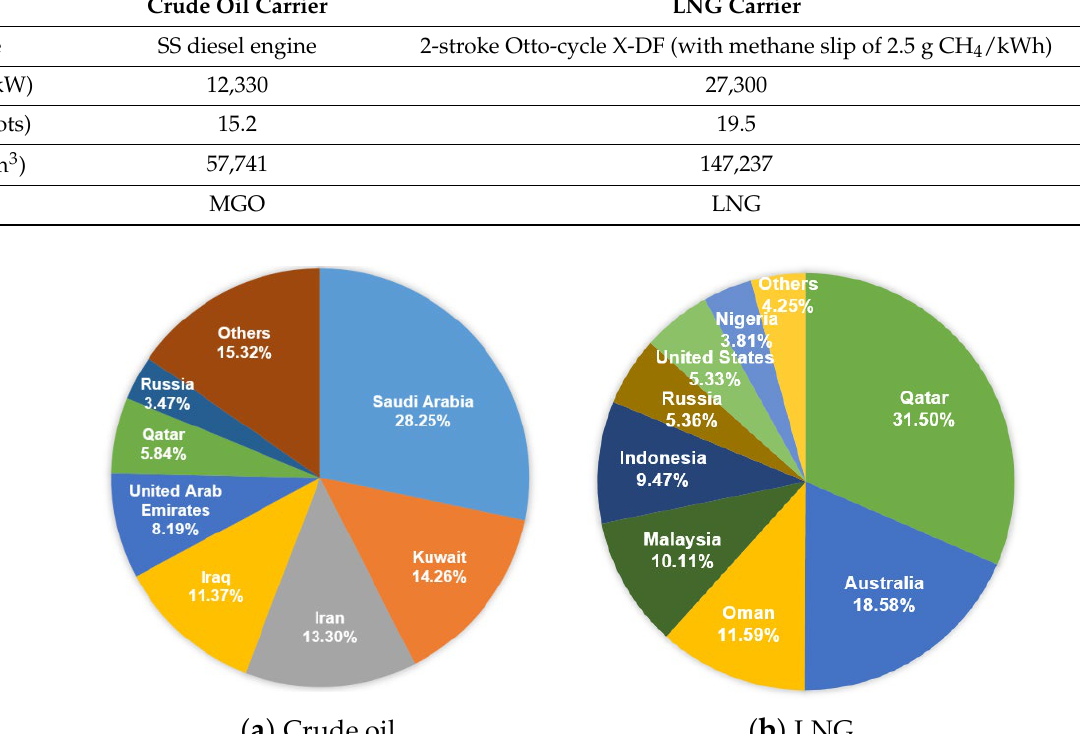
Table 1. Specifications of crude oil and LNG carrier in the well-to-tank phase [33].